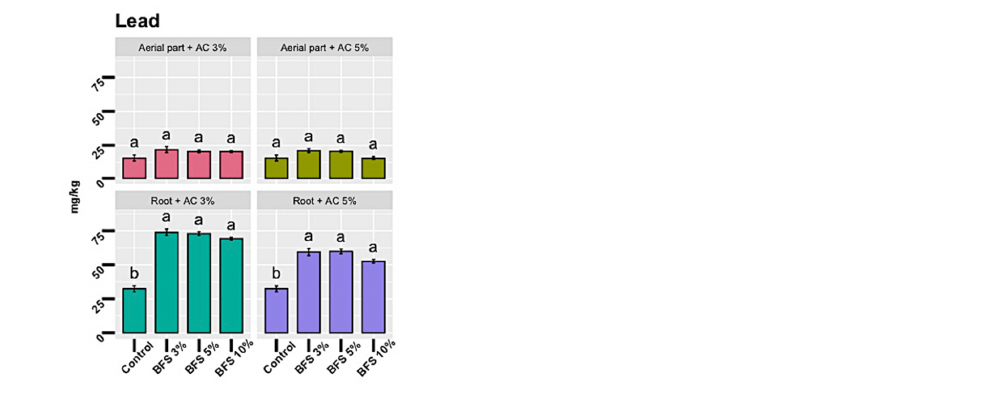
Figure 8. PTE content in roots and aerial parts of plants with the amendment of Blast Furnace Slag (BFS) and Activated Carbon (AC).